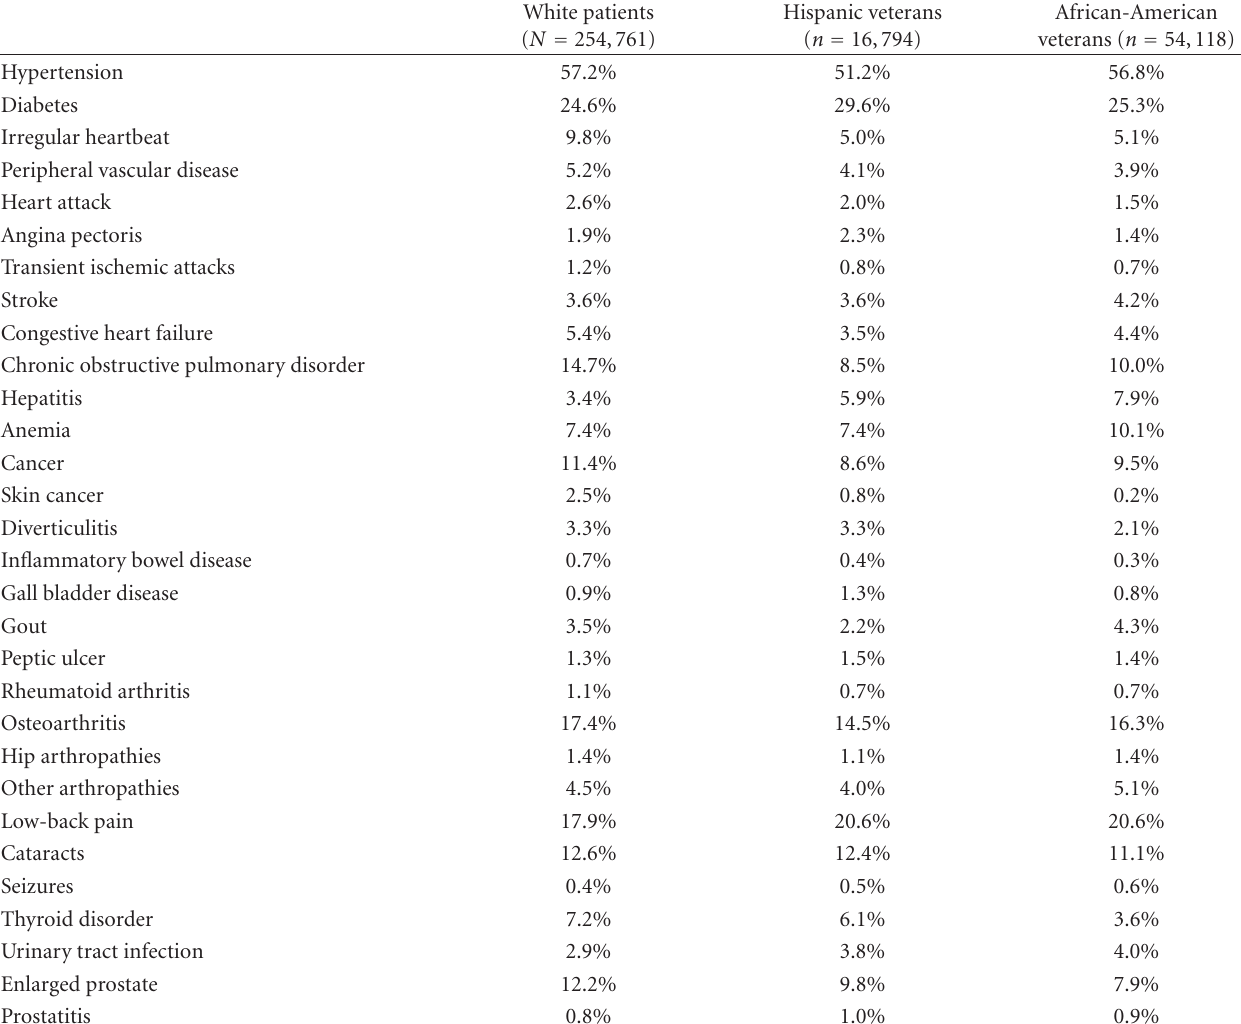
Table 3: Distribution of selim chronic comorbid conditions for major minority race and ethnicity